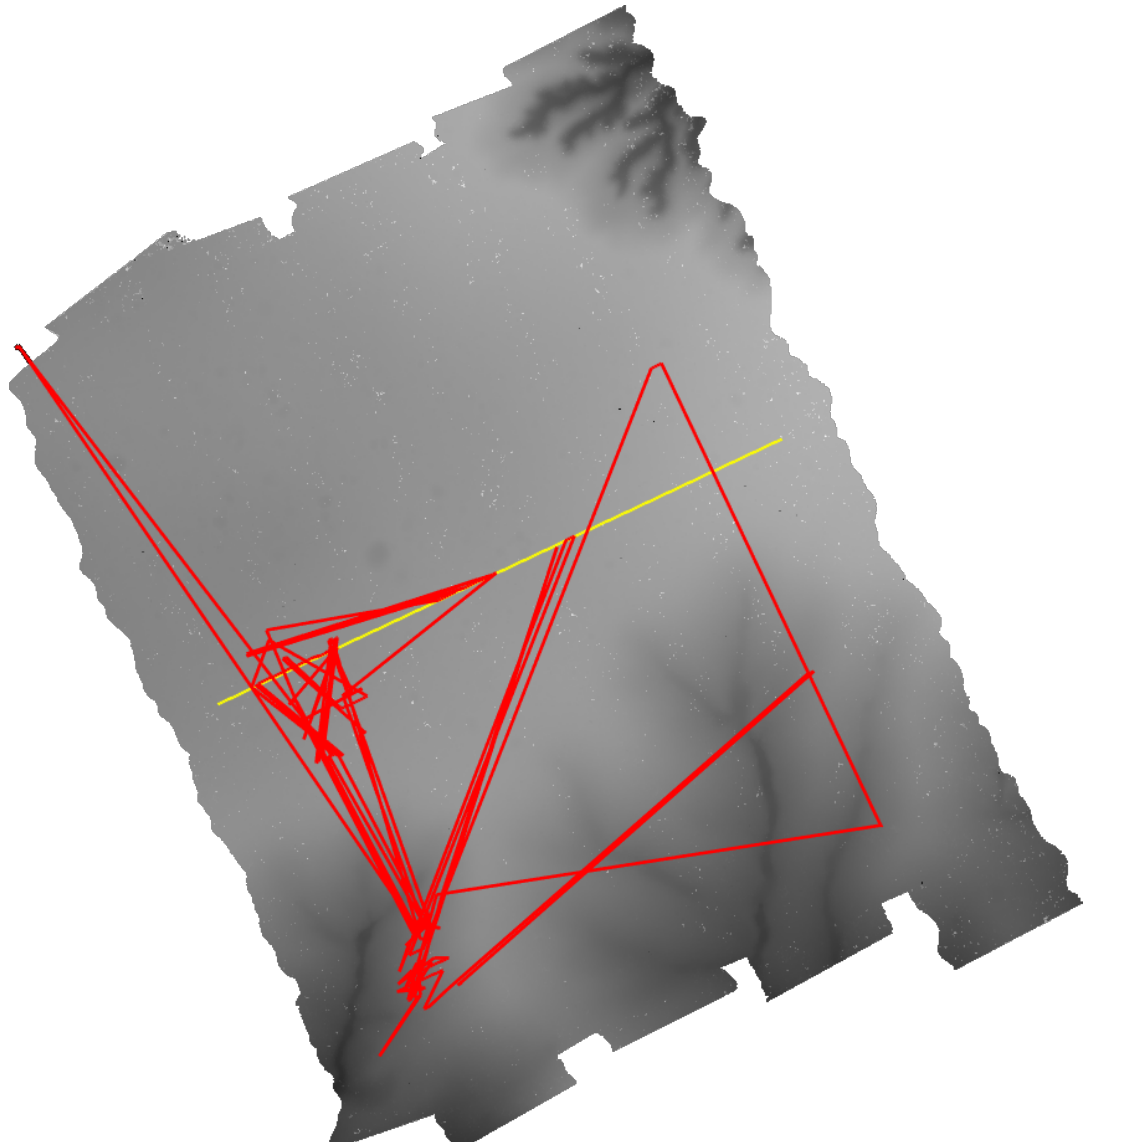
Figure 22. Trajectory in yellow on terrain, circular bin, experiment. Corresponding estimated positions are drawn in